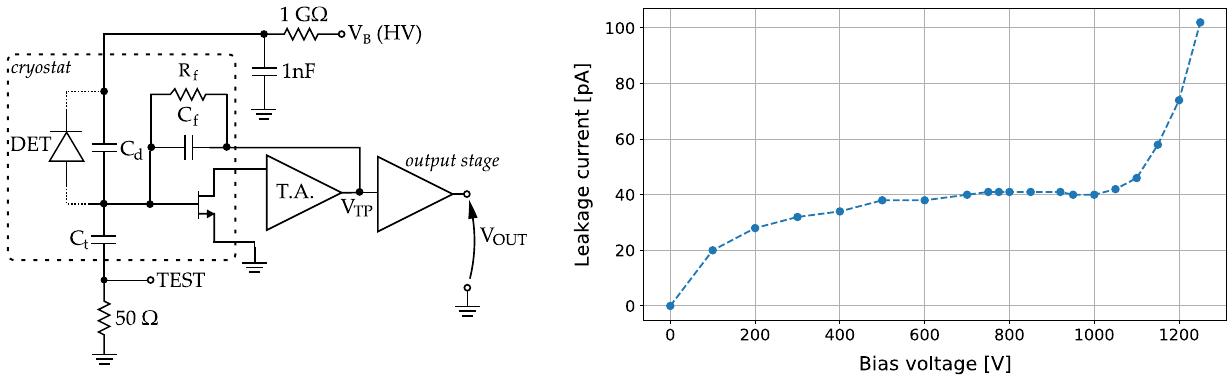
Fig. 2 Left panel: schematic of the preamplifier circuit. The test point voltage ( V TP ) was used to determine the leakage current (see the text for the explanation). Right panel: leakage current of the fabricated detector as a function of the bias voltage. The operating voltage was set to 1100V